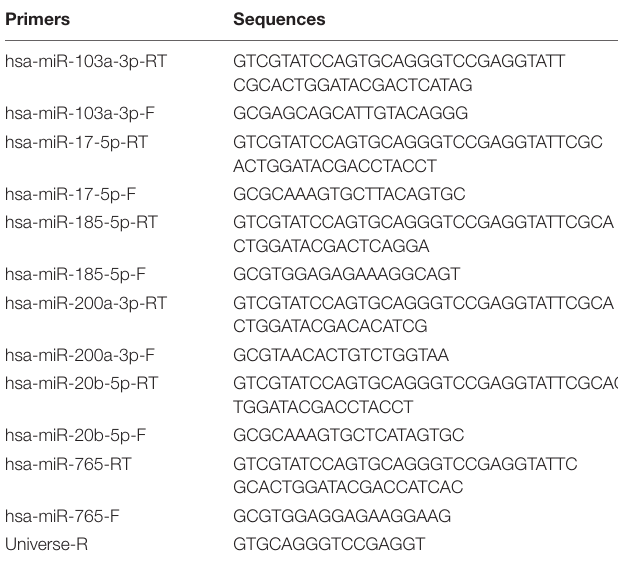
TABLE 2 | Primer sequence for miRNA